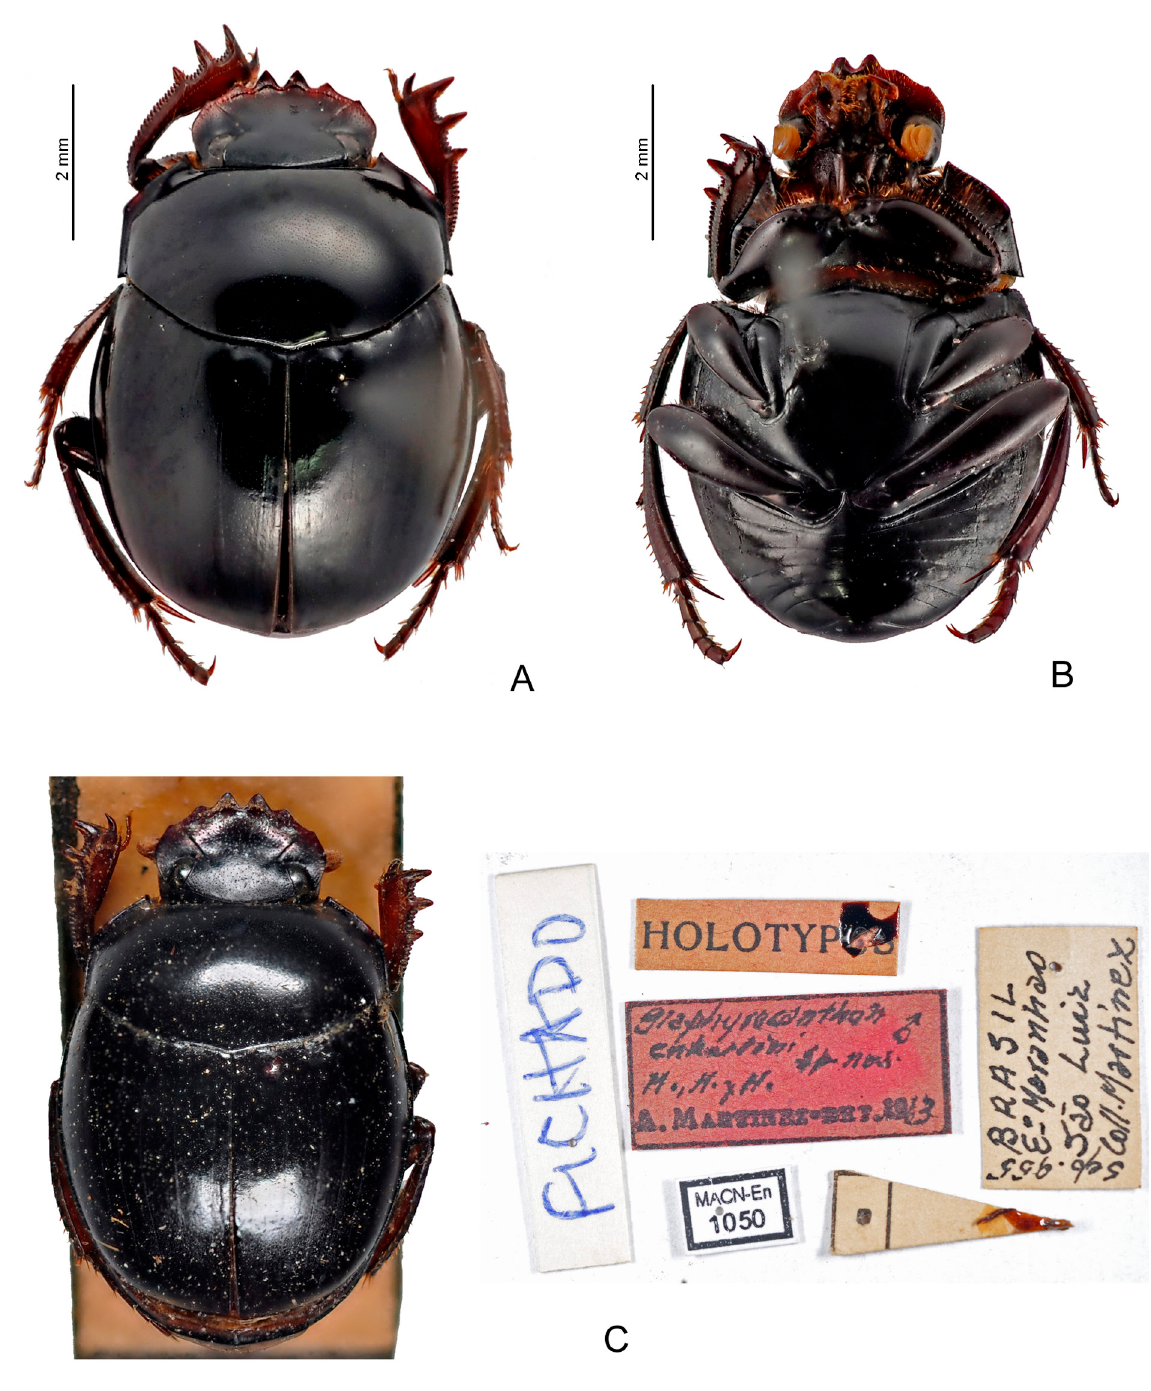
Fig. 21. Sylvicanthon enkerlini (Martínez et al. , 1964) comb. nov. A . Dorsal view. B . Ventral view. C . Holotype and its